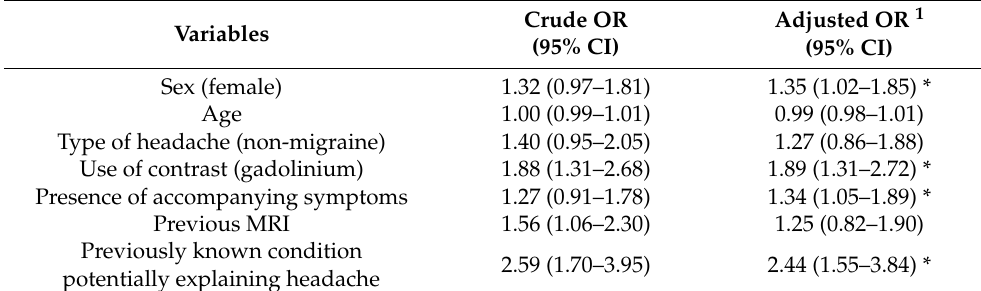
Table 4. Multivariate logistic regression models for the diagnosis of structural findings explaining headache on magnetic resonance imaging